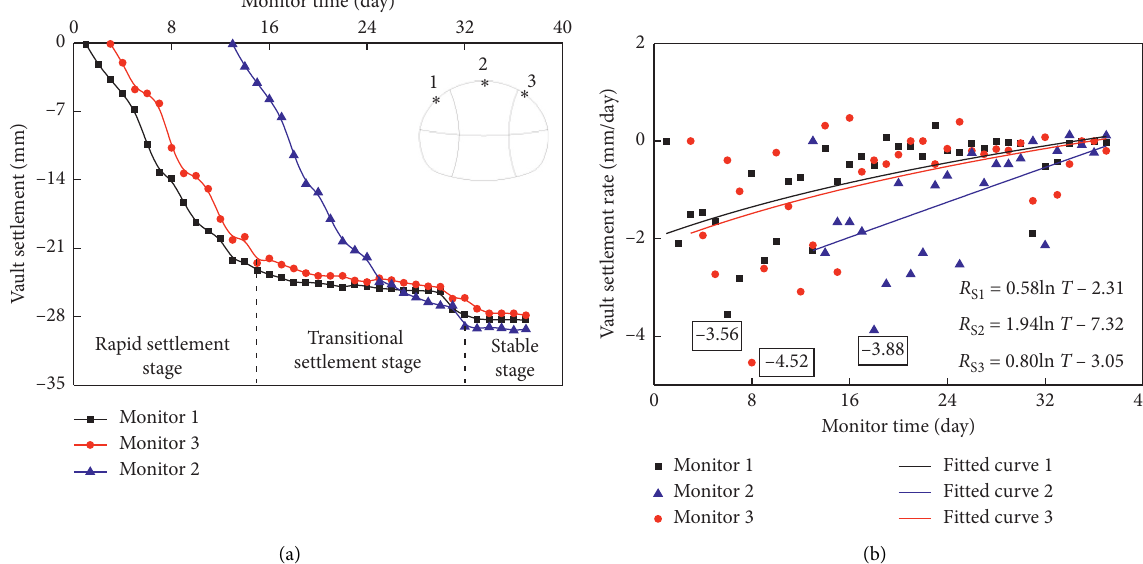
Figure 18: Vault settlement characteristics. (a) Time-history curves of vault settlement. (b) Time-history curves of the change rate of vault